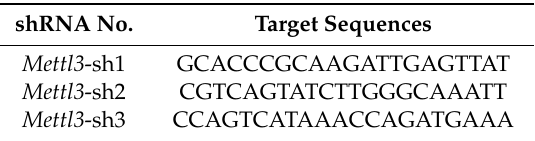
Table 1. Sequences of Mettl3 -shRNA.